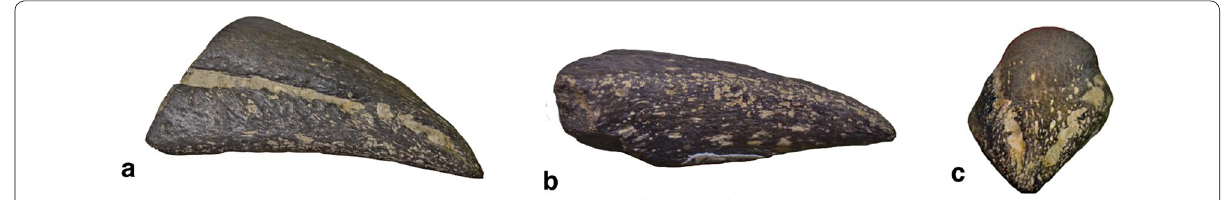
Fig. 11 Pedal ungual tentatively referred to Schleitheimia schutzi n. gen., n. sp., PIMUZ A/III 547. a lateral view; b dorsal view; c anterior view. Scale bar equals 1 cm